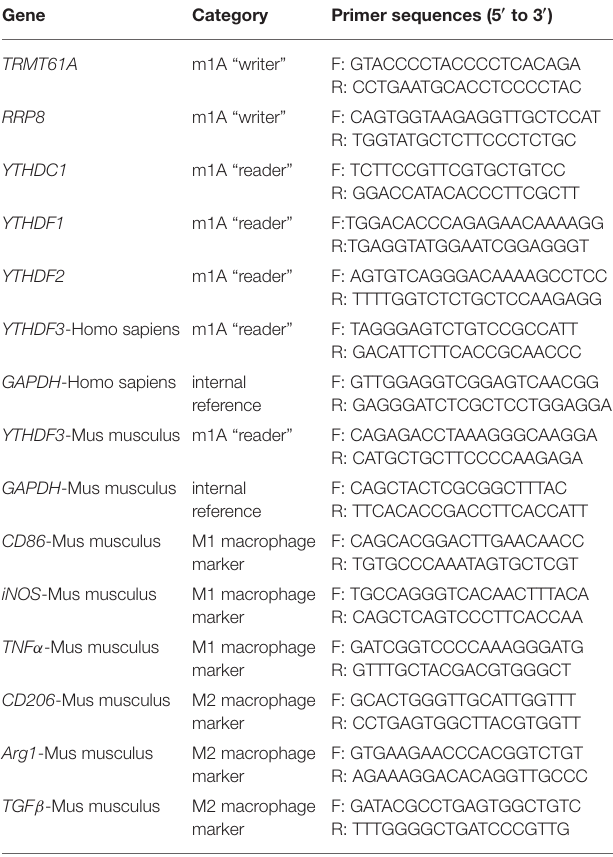
TABLE 1 | Primer sequences used for